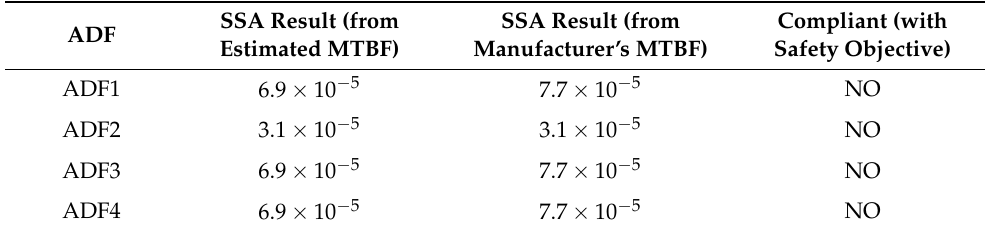
Table 7. SSA results of erroneous (or unannuciated) ADF failure conditions estimated starting from the MTBF of ADS sub-parts and compared with the safety objective < 1 × 10 − 6 defined in Section